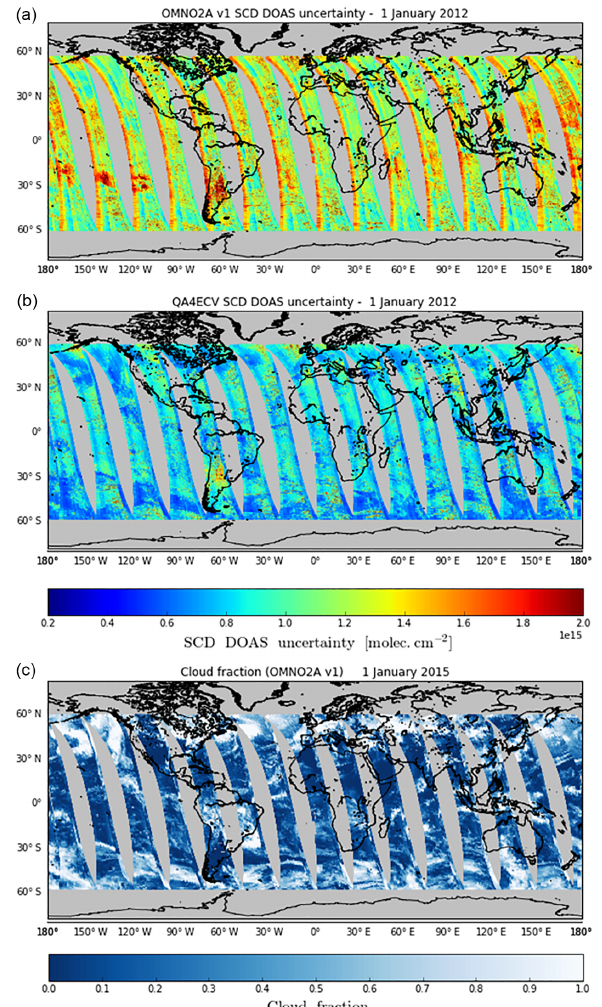
Figure 8. NO 2 DOAS SCD uncertainty from the OMNO2A v1 (a) and OMINO2–QA4ECV (b) algorithms on 1 January 2012. Panel (c) shows the cloud fractions from the OMCLDO2 retrieval for the same